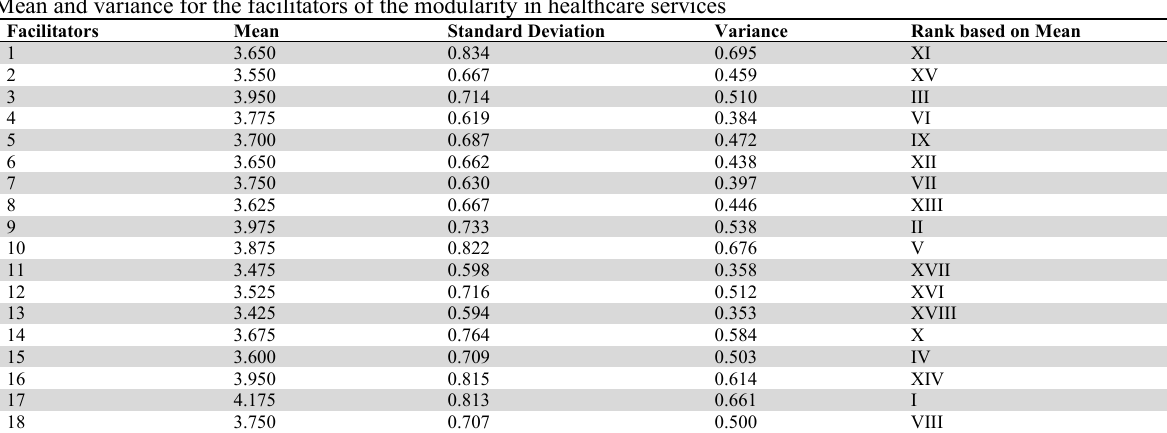
Mean and variance for the facilitators of the modularity in healthcare services Facilitators